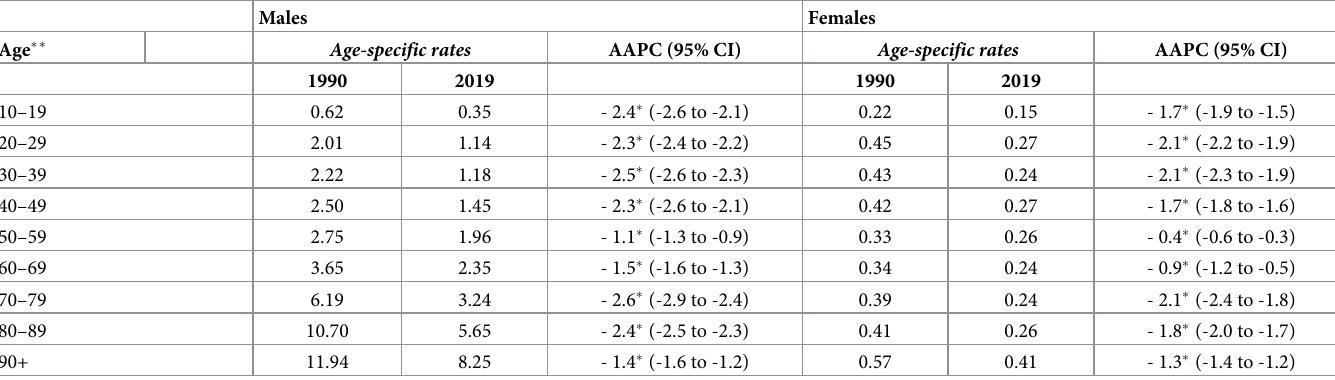
Table 1. Joinpoint regression analysis: Global trends � in age-specific mortality rates (per 100,000) of suicide by firearm, by sex, 1990–2019. Males Females Age �� Age-specific rates AAPC (95%